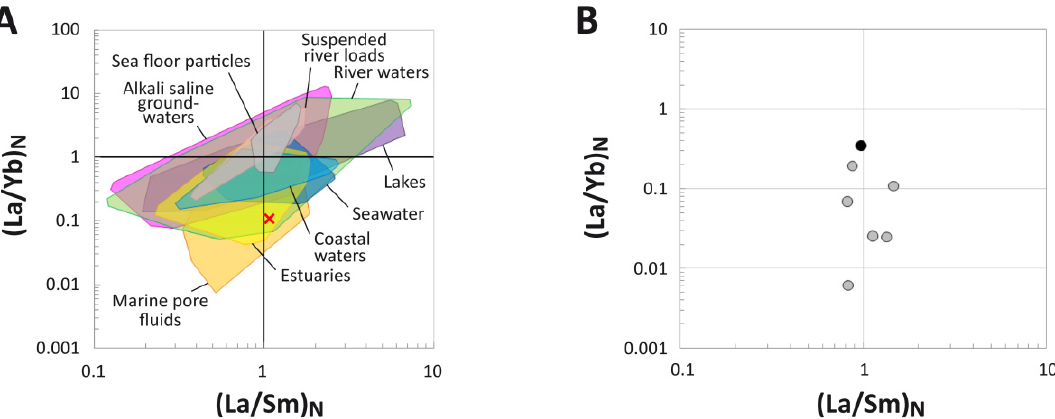
Figure 5. (La/Yb) N and (La/Sm) N ratios of the tibia of MOR 2598. ( A ) Comparison of the whole-bone average (La/Yb) N and (La/Sm) N ratios of the fossil to ratios from various environmental waters and sedimentary particulates. Literature sources for environmental samples are provided in the Supplementary Materials. ( B ) REE compositions of individual laser transects expressed as NASC-normalized (La/Yb) N and (La/Sm) N ratios. The transect including the external bone margin is denoted by the black symbol, whereas all other (internal) transects are represented by gray symbols.